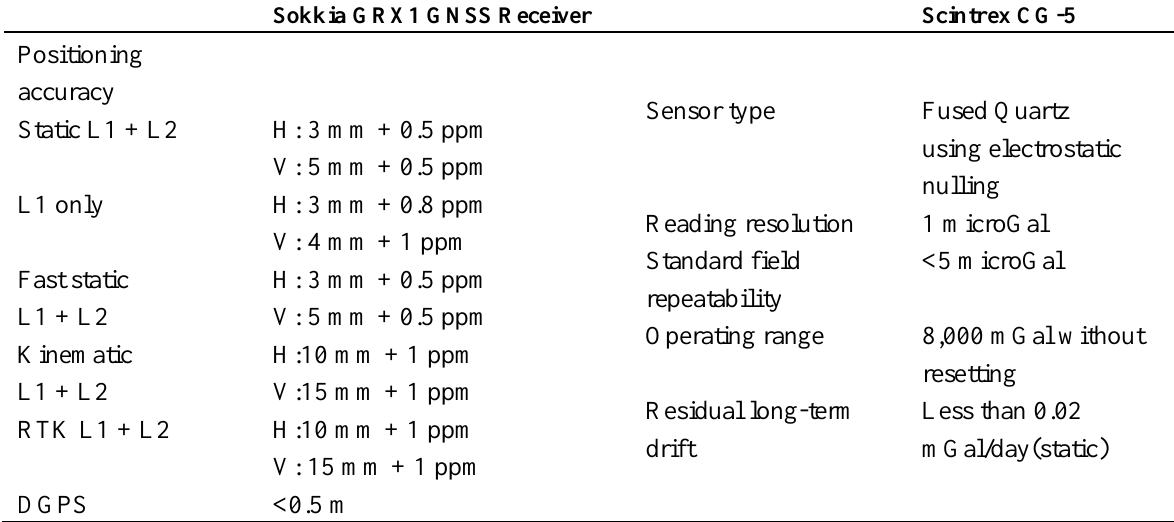
Table 1. Equipment specifications [1,22].